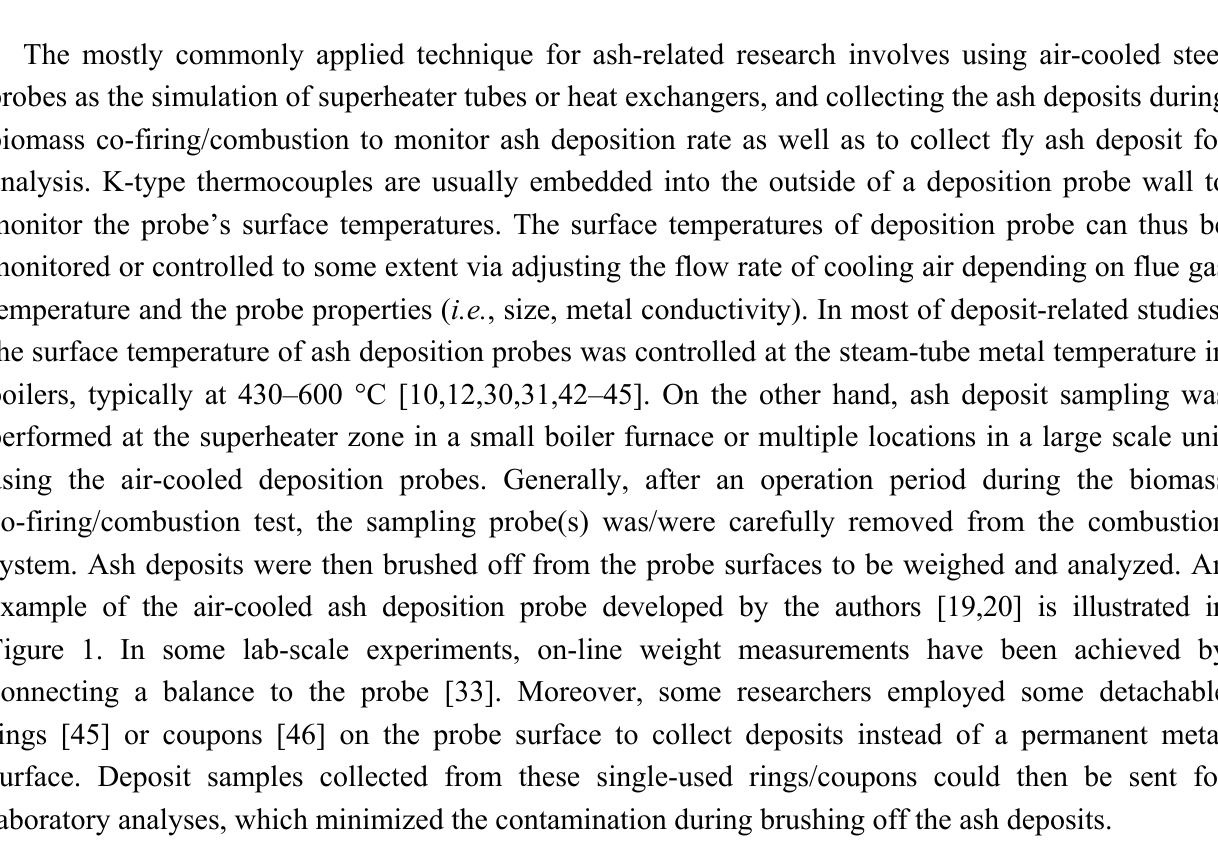
Figure 1. Air-cooled ash deposition